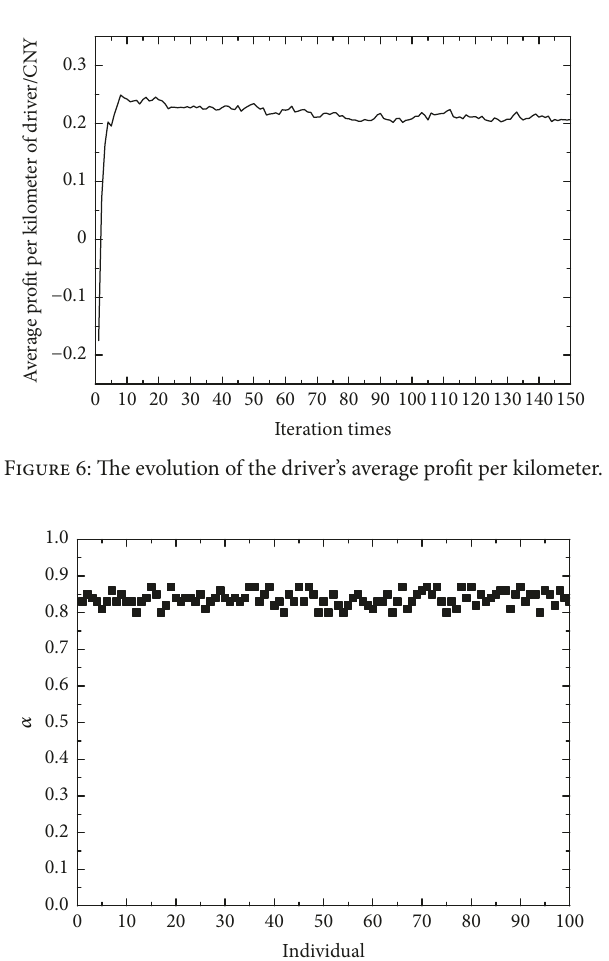
Figure 7: The value 𝛼 of carpooling states.